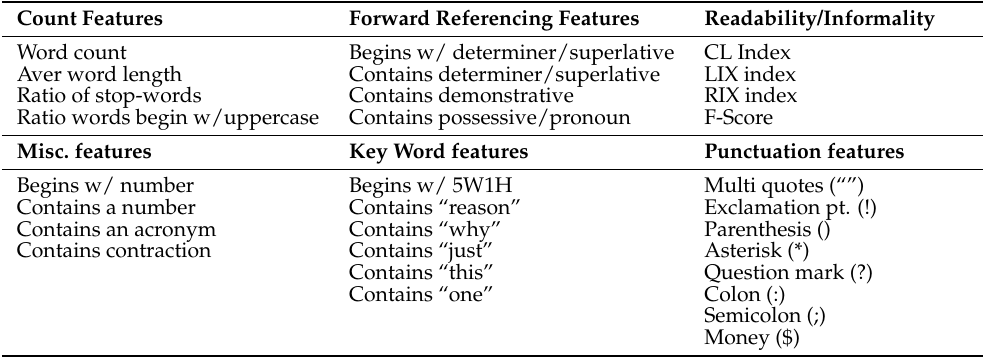
Table 1. Key semantic classification features.